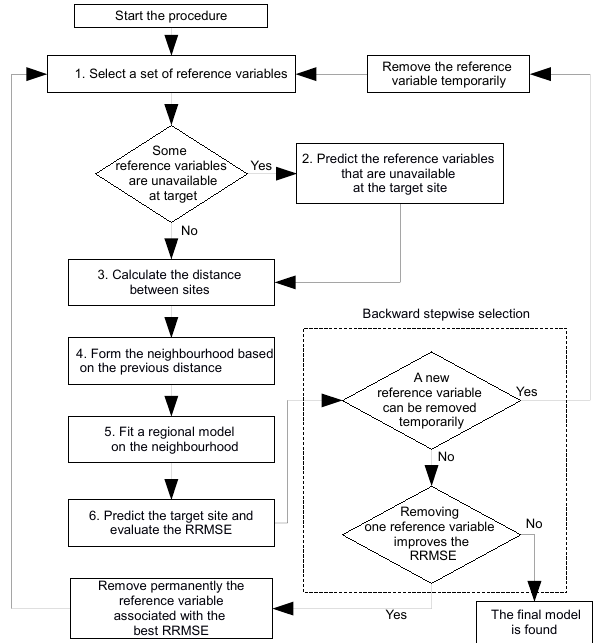
Figure 1. Diagram of the RVN method using backward step-wise